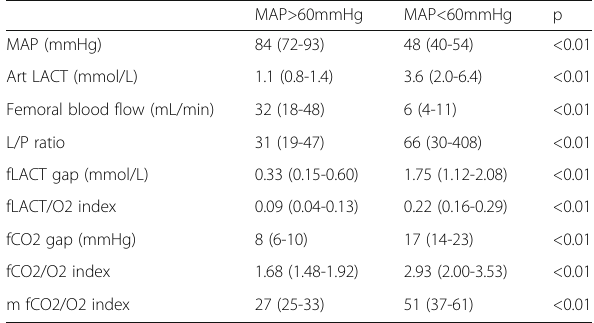
Table 85 (abstract A264). Median values before and after